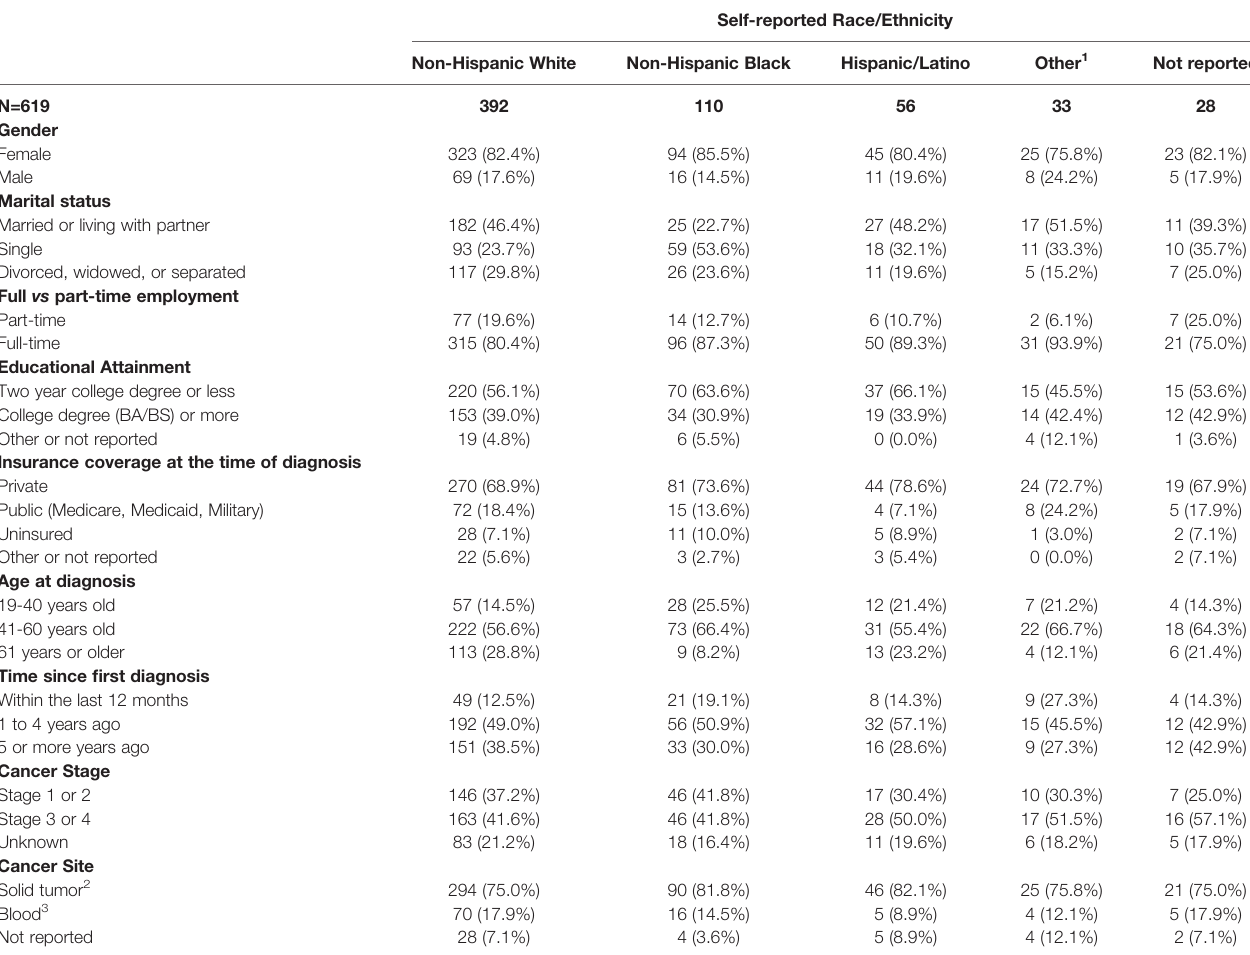
TABLE 1 | Descriptive statistics from a sample of employed patients with cancer who received assistance from a national non-pro fi t, strati fi ed by self-reported race/ ethnicity (Oct – Nov